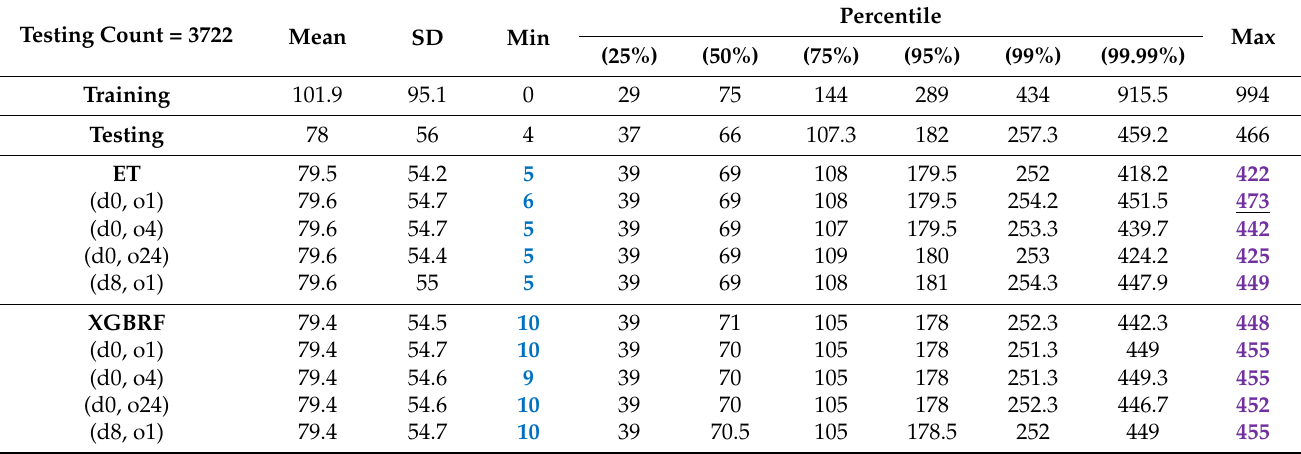
Table 9. Output statistics of Extra Trees and XGBRF along with NARX vs. the training and testing output for the seventh iteration for the Beijing dataset.